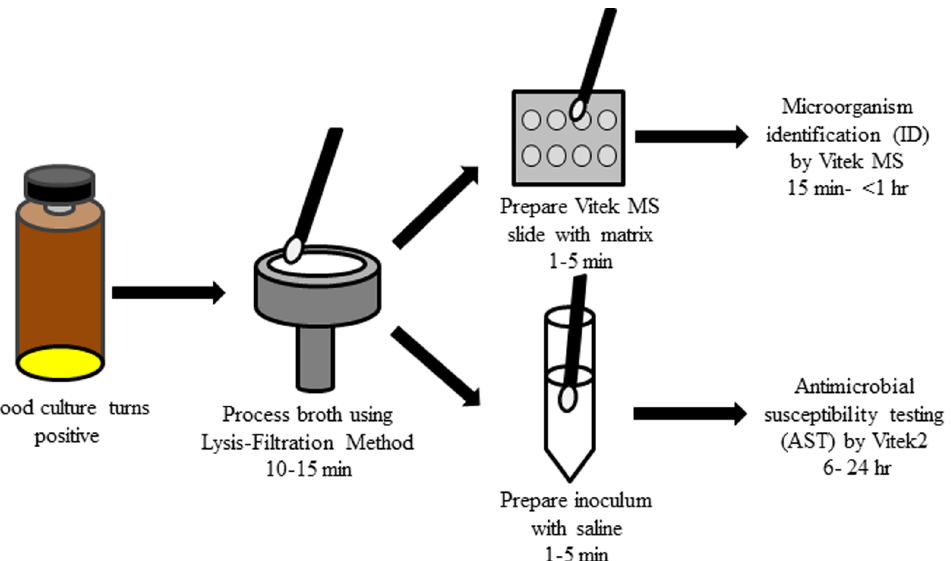
Figure 1. Process flow diagram for identification and antimicrobial susceptibility testing of bacteria directly from positive blood culture bottles using the Lysis-Filtration Method with MALDI-TOF VITEK Mass Spectrometry and the VITEK H 2 System.